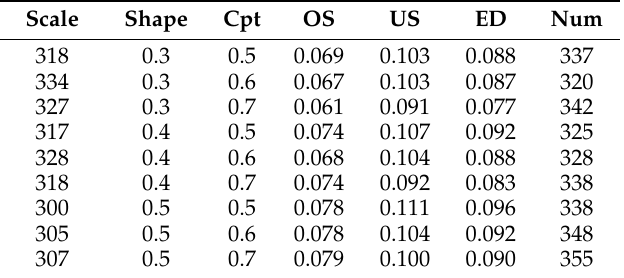
Table 7. Segmentation accuracy metrics for Ansai based on OSRH